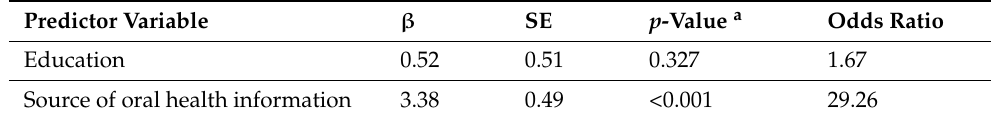
Table 7. Multivariate analysis between interdental cleaning and independent variables.